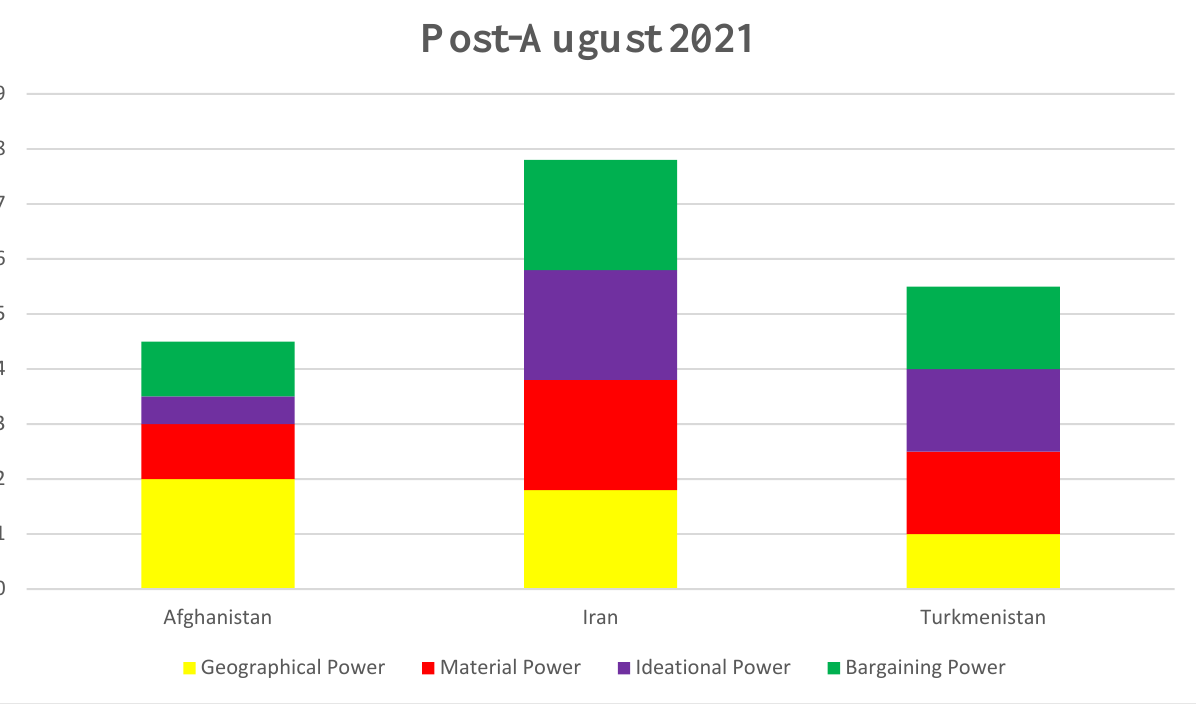
Figure 3. The illustration of power dynamic in four pillars of the Hydro-hegemony Framework in the Harirud River Basin after August 2021.